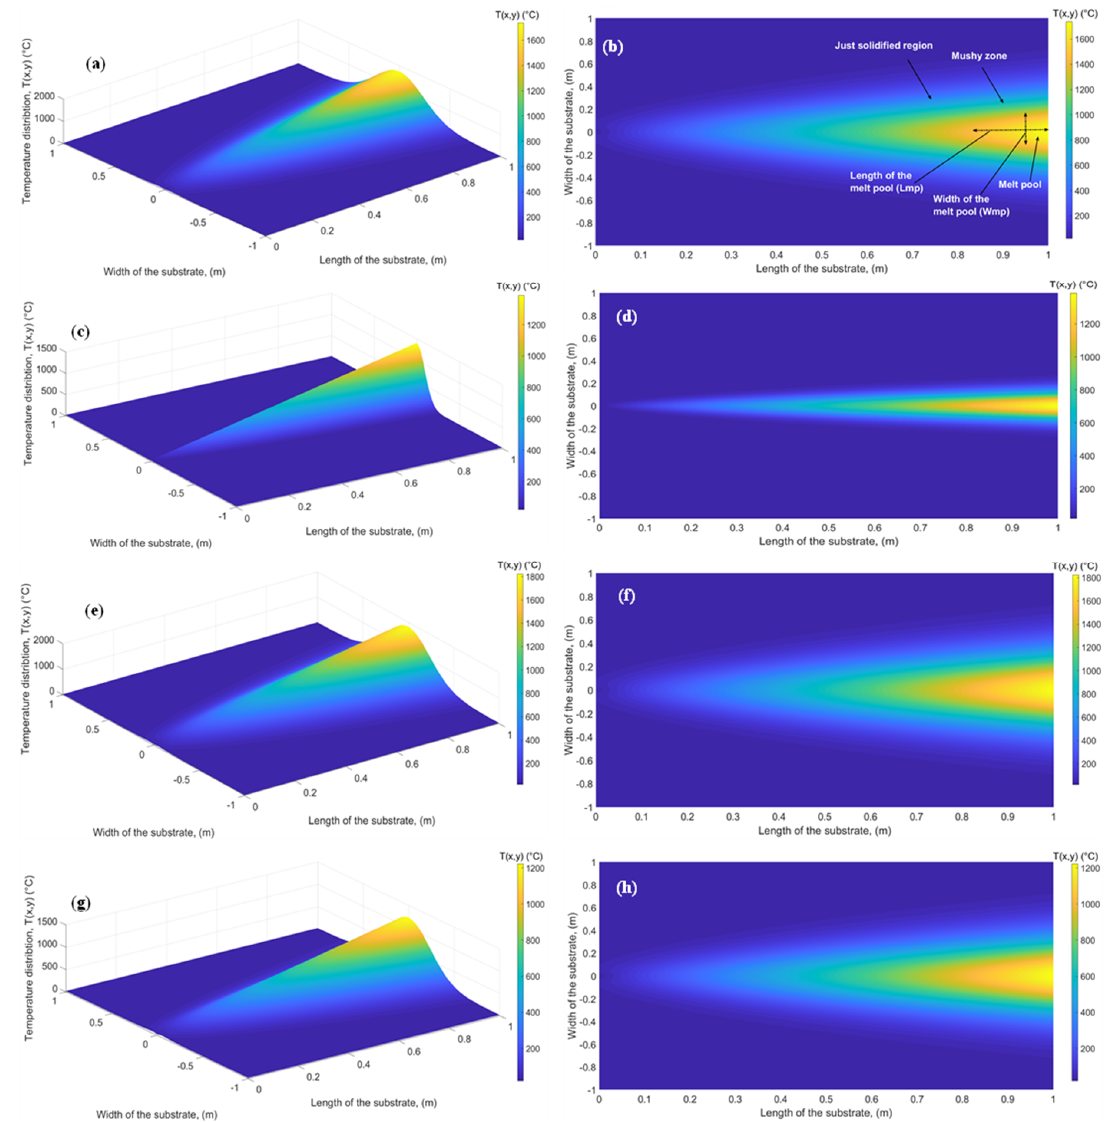
Figure 8. Temperature profiles for Ti6Al4V alloy when ( a ) P = 400 W, v l = 0.3 m/min, ( b ) 2D plot of ( a ), ( c ) P = 400 W, v l = 0.35 m/min, ( d ) 2D plot of ( c ), ( e ) P = 500 W, v l = 0.3 m/min, ( f ) 2D plot of ( e ), ( g ) P = 400 W, v l = 0.3 m/min with the co-axial addition of powder debits, and ( h ) 2D plot of ( g ).